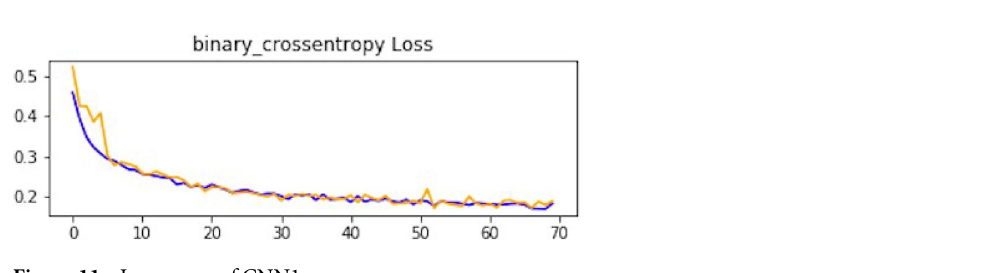
Figure 11. Loss curve of CNN1.